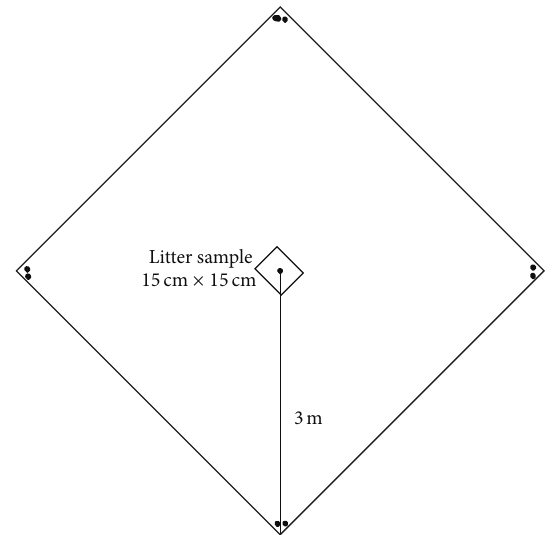
Figure 2: Diagram of plot design. Two soil cores were taken at the center and at each